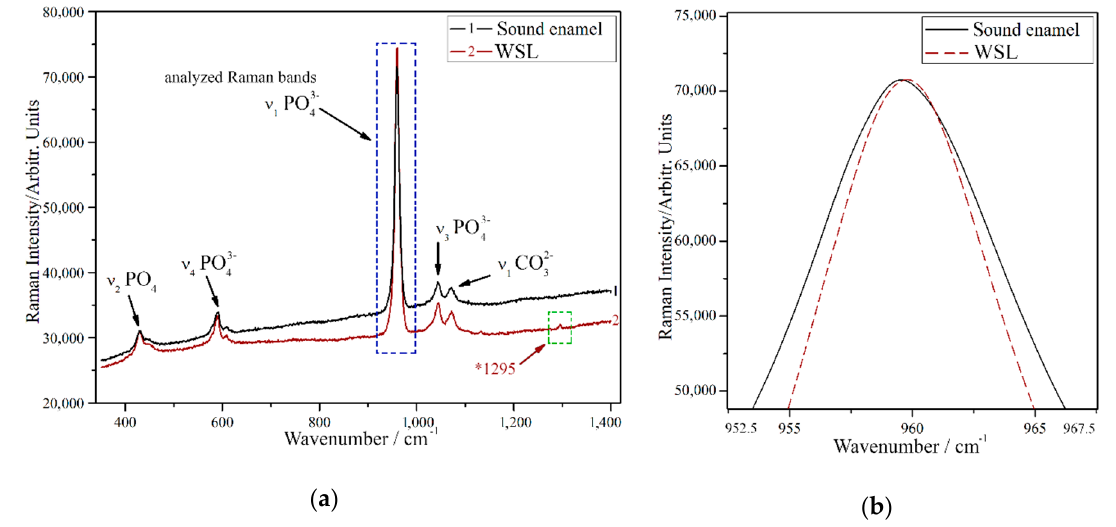
Figure 6. Results of the Raman spectroscopy research: ( a ) spectra sound enamel and WSL (average of four spectra each); ( b ) the shift of the most intense band position due to the carious process.